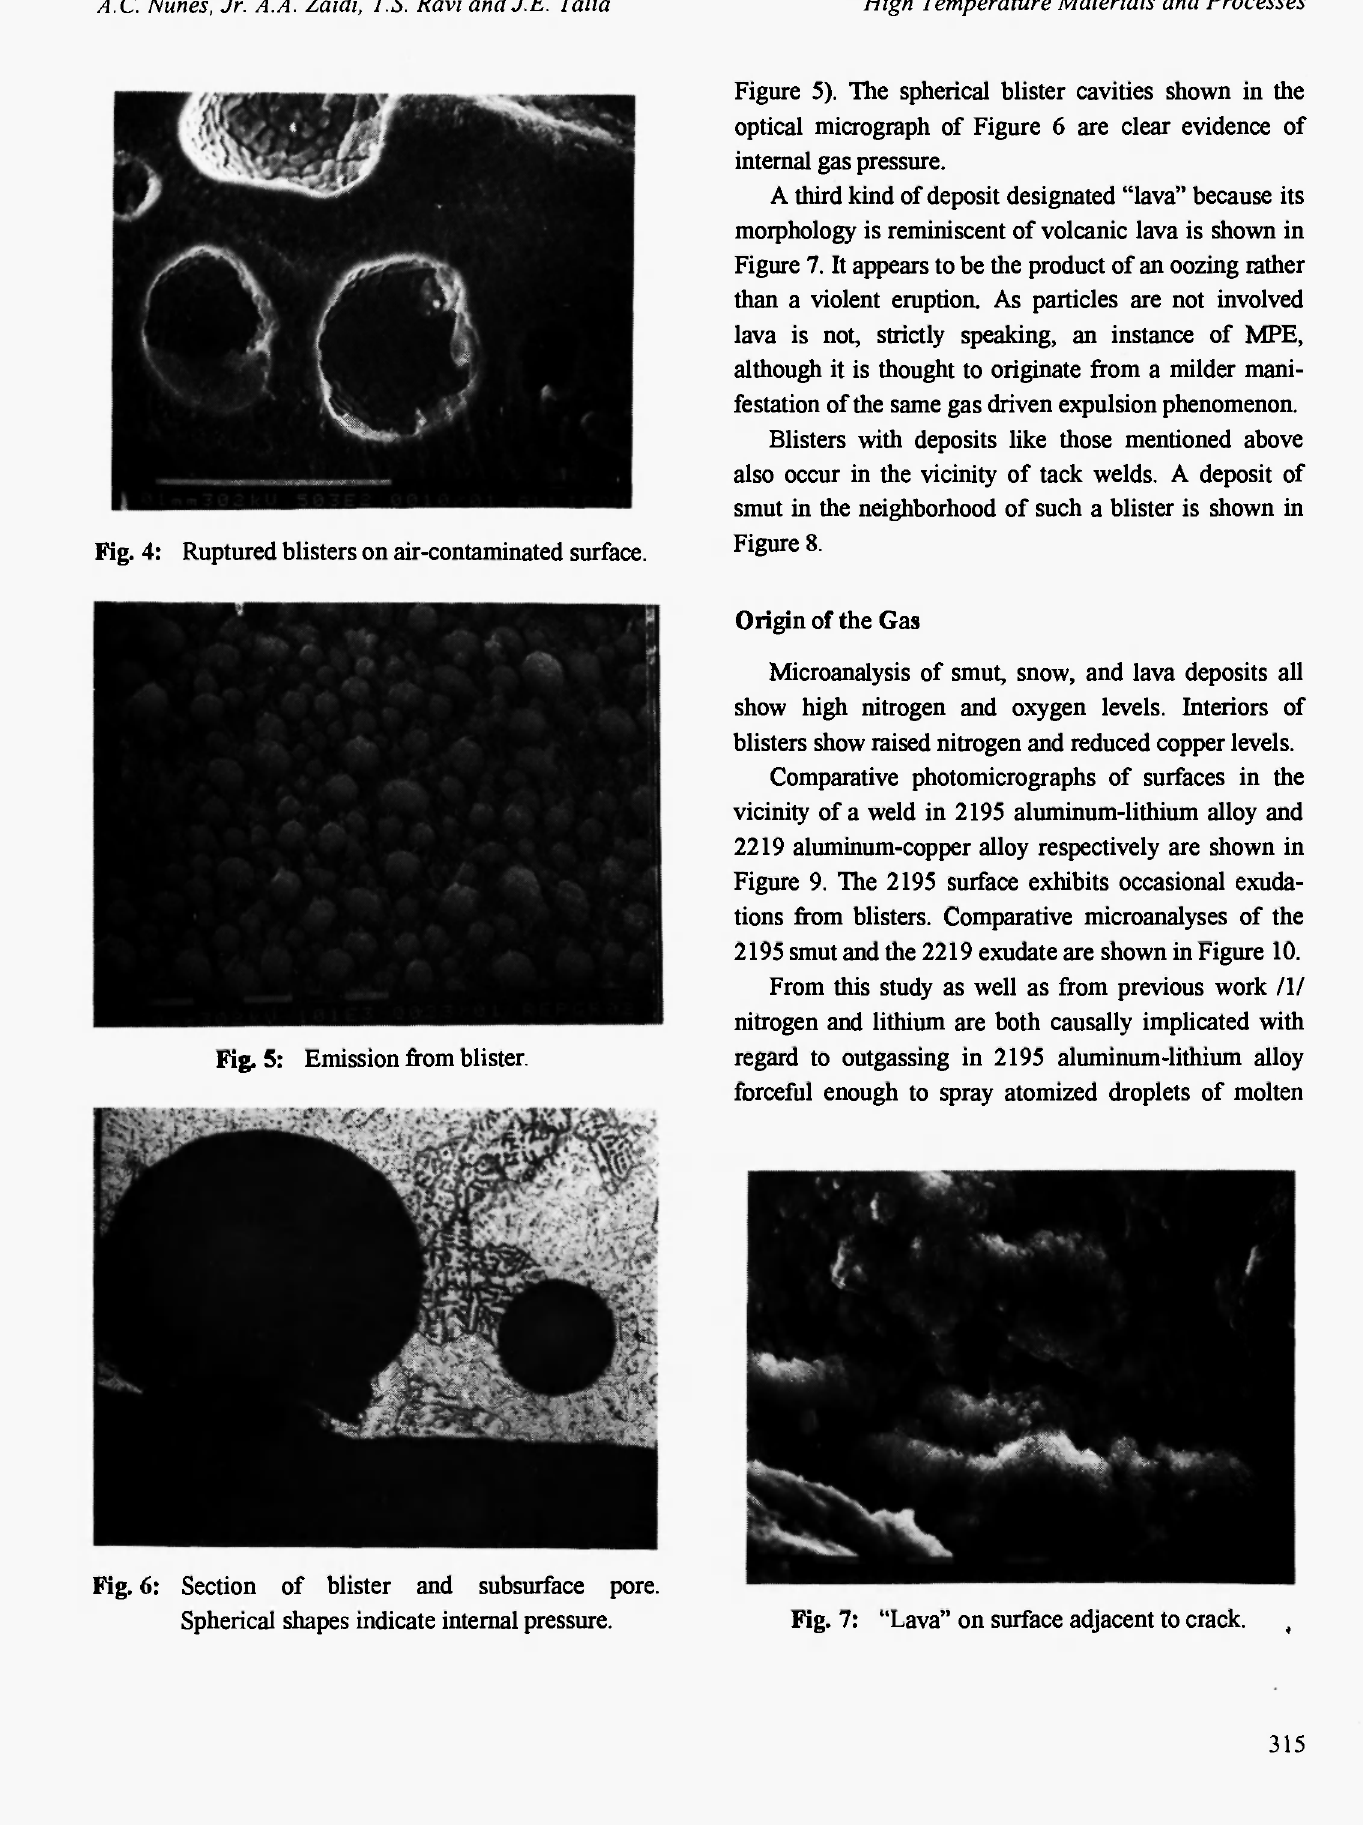
Fig. 4: Ruptured blisters on air-contaminated surface.